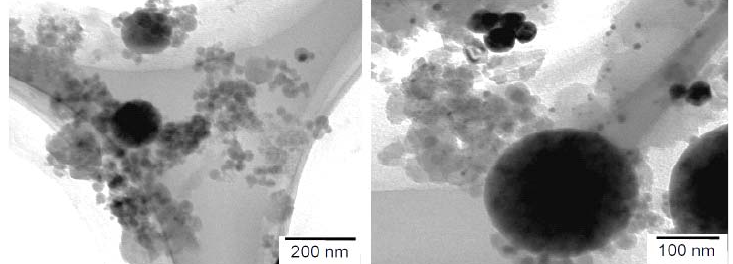
Fig. 2. TEM images of gold nanoparticles synthesized from Frangipani flower spherical morphology .